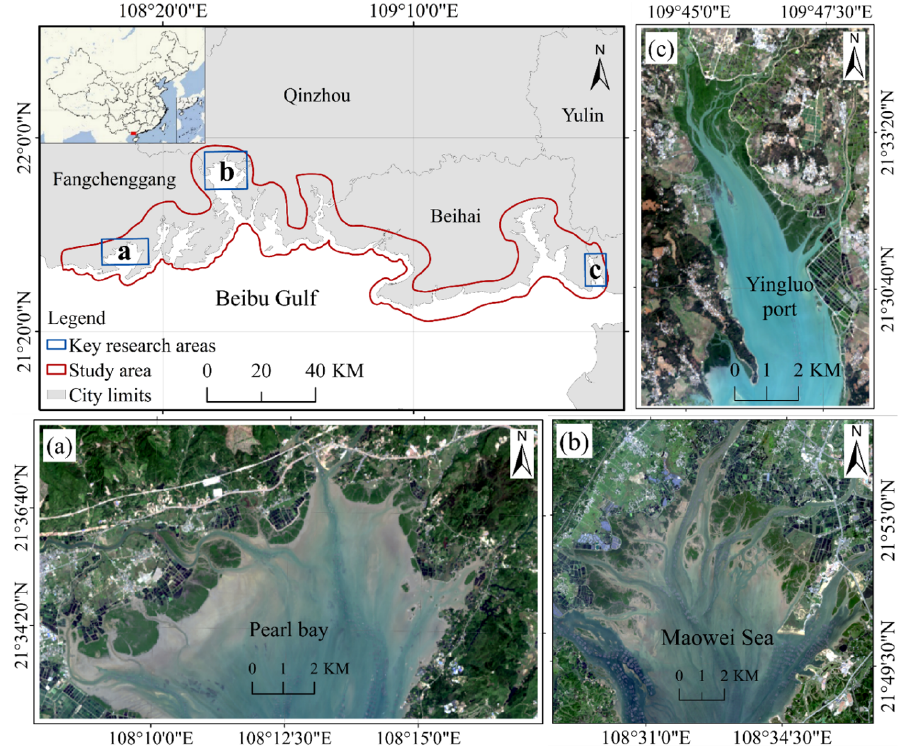
Figure 1. Geographical location of the study area. ( a ) Pearl Bay Mangrove Reserve. ( b ) Maowei Sea Mangrove Reserve. ( c ) Shankou Mangrove Reserve.